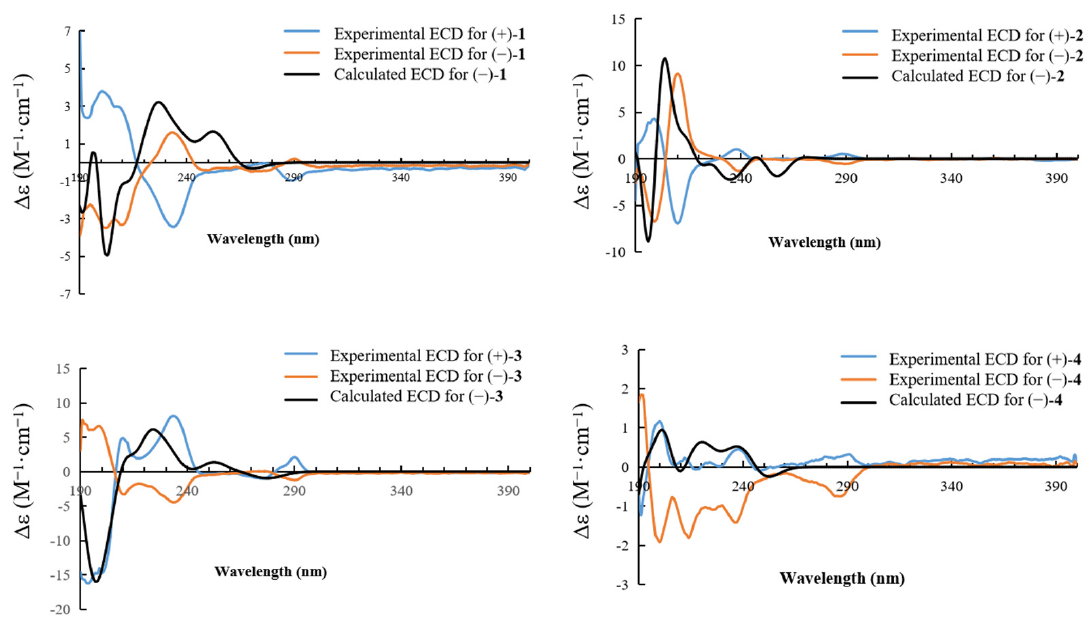
Figure 3. ECD spectra of compounds 1 , 2 , 3 , and 4 in MeOH.